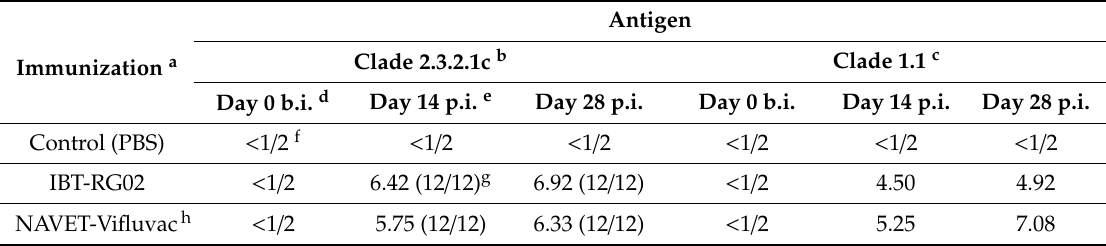
Table 2. Antibody production in chickens after immunization with the rescued recombinant H5N1 virus.